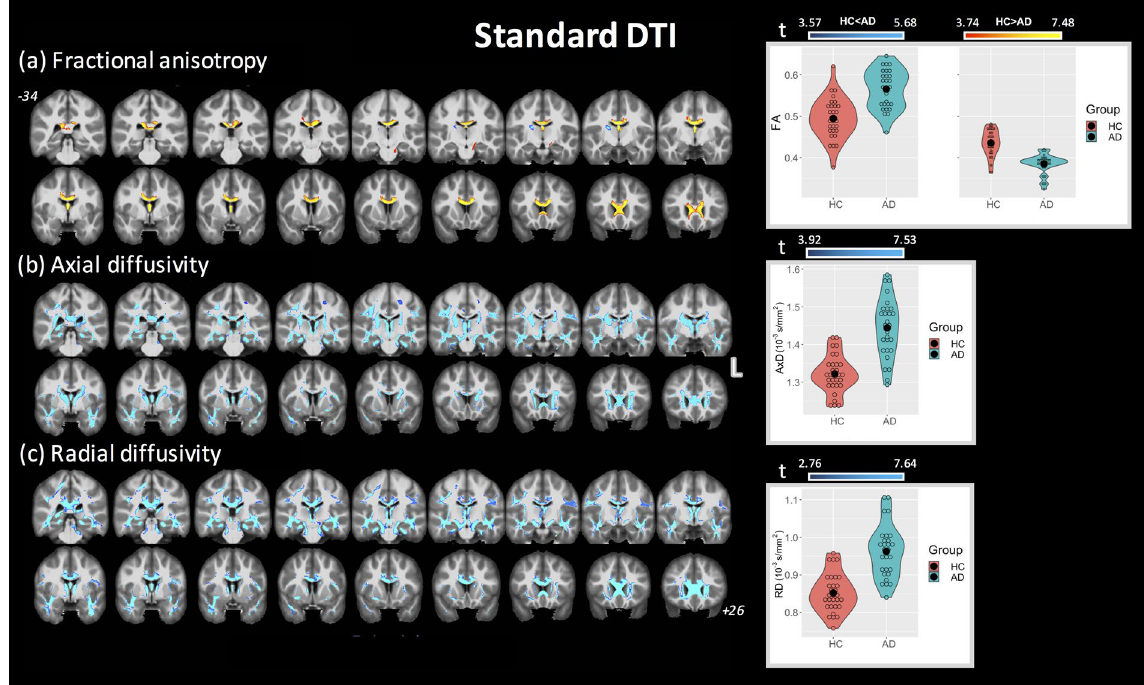
Figure 1. Coronal view of ANCOVA analysis between HC and AD subjects for standard DTI metrics. Clusters are reported at a significance threshold of p -value < 0.01 corrected for FWE. ( a ) FA, ( b ) AxD, and ( c ) RD analysis. The color bars indicate values that are lower in AD than HC (red-to-yellow) and higher in AD than HC (blue-to-cyan). For axial and radial diffusivities, only clusters with higher values in AD than HC were found. The corresponding violin plots represent the DTI metrics inside the significant clusters for each